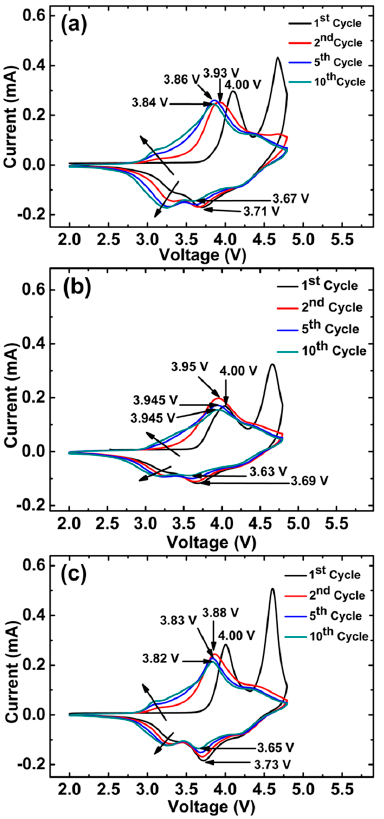
Figure 8. Cycle voltammetries of (a) LRAC, (b) LRNI, and (c) LRACNI; at a scan rate of 0.1 mV/s, between 2.0 – 4.8 V.